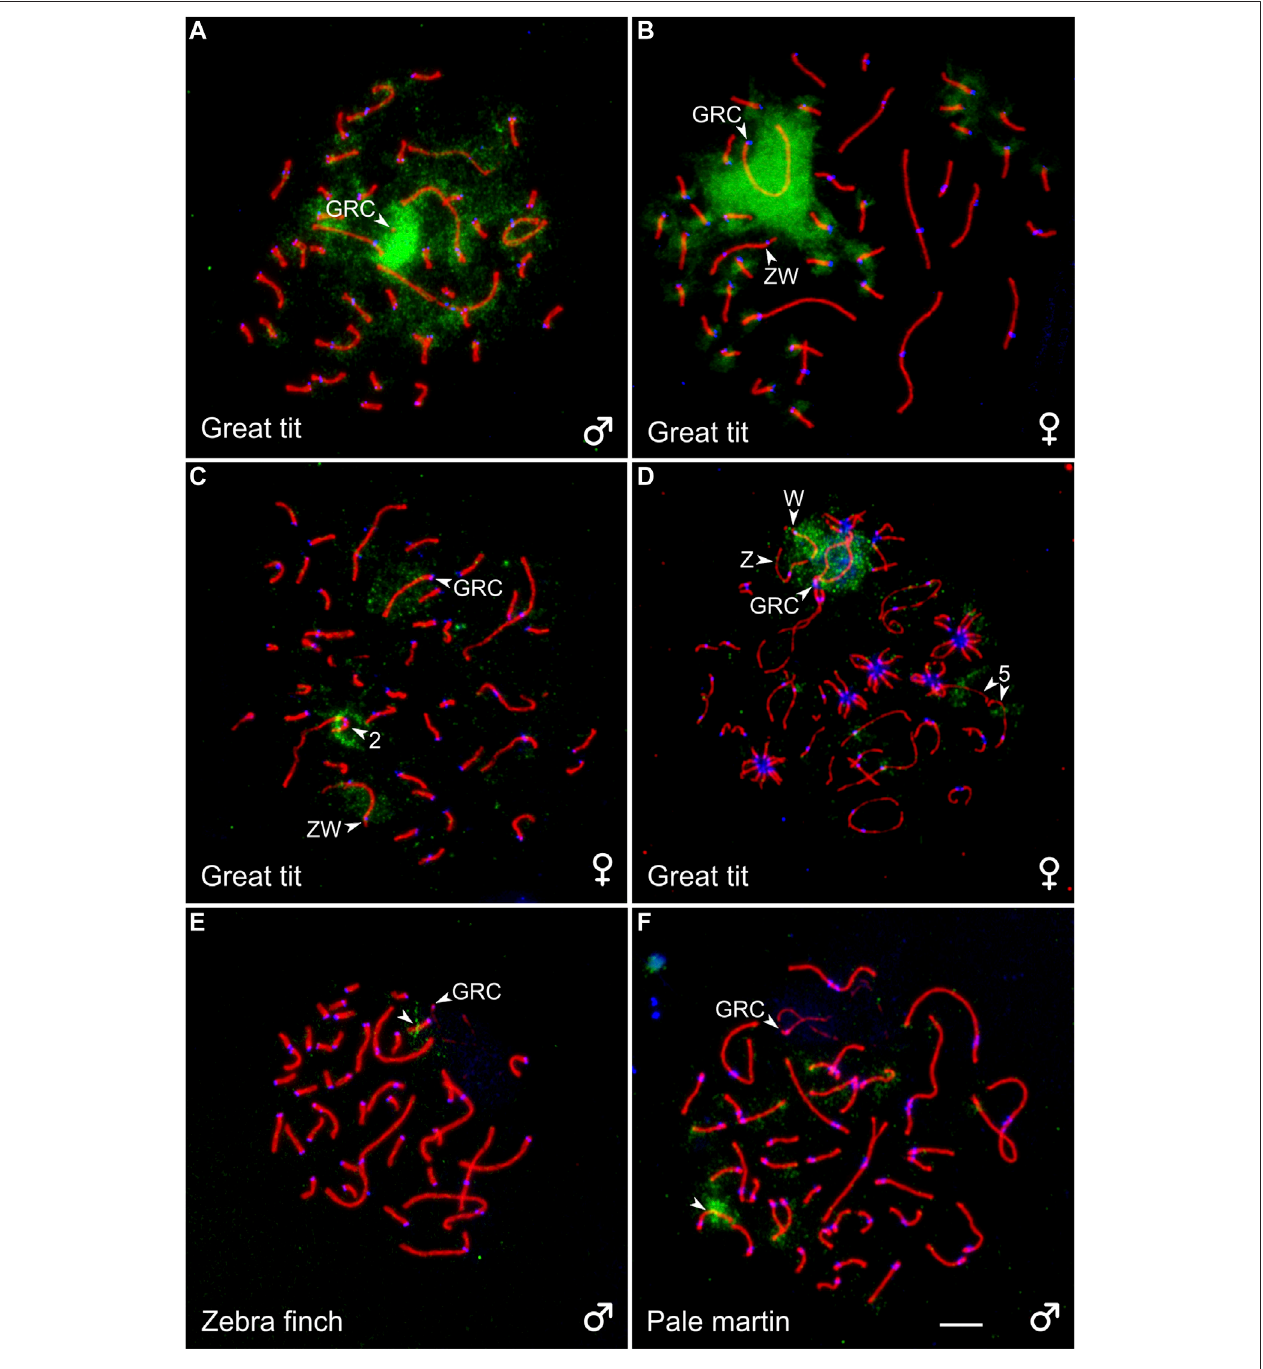
FIGURE 3 | SC spreads of the great tit (A – D) , zebra fi nch (E) , and pale martin (F) after reverse FISH with the great tit GRC probe (green) without (A) and with (B) suppression of repetitive sequences using C 0 t-1 DNA of the great tit and cross-species FISH with DNA probes (green) derived from GRC of the zebra fi nch (C) , pale martin (D) , and great tit (E, F) . Spreads were immunolabeled with antibodies against SYCP3 (red) and centromere proteins (blue). The arrowheads point to macrobivalents 2 and 5, sex bivalent ZW, GRC and microbivalents with hybridization signals. Bar — 5 µm.